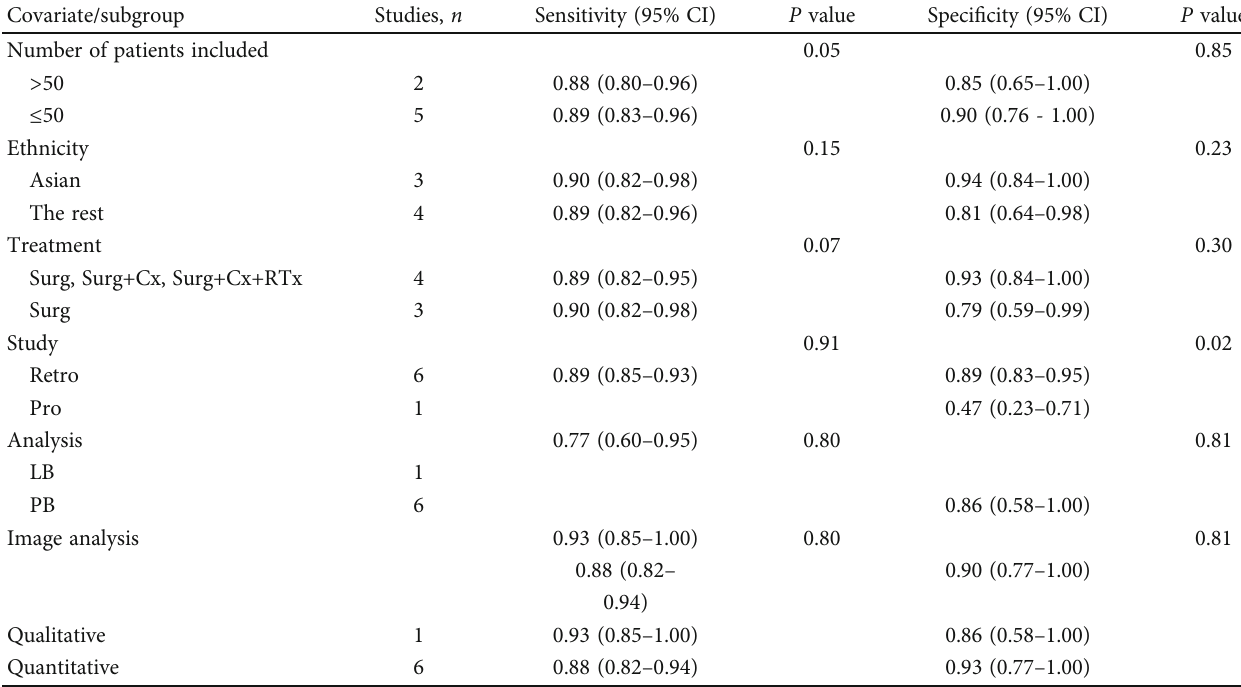
Table 3: Subgroup analysis of diagnostic performance of 18F-FDG PET/CT.